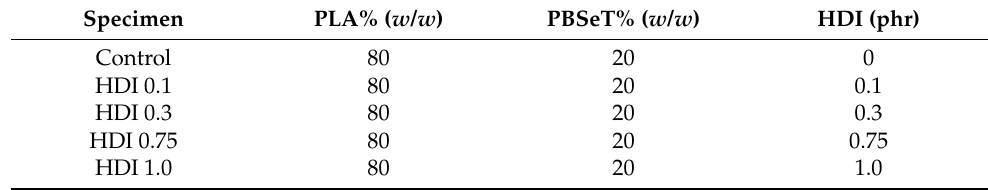
Figure 1. Chemical structures of blend and reactant. Table 1. Chemical compositions of PLA/PBSeT blends prepared with various HDI ratios.